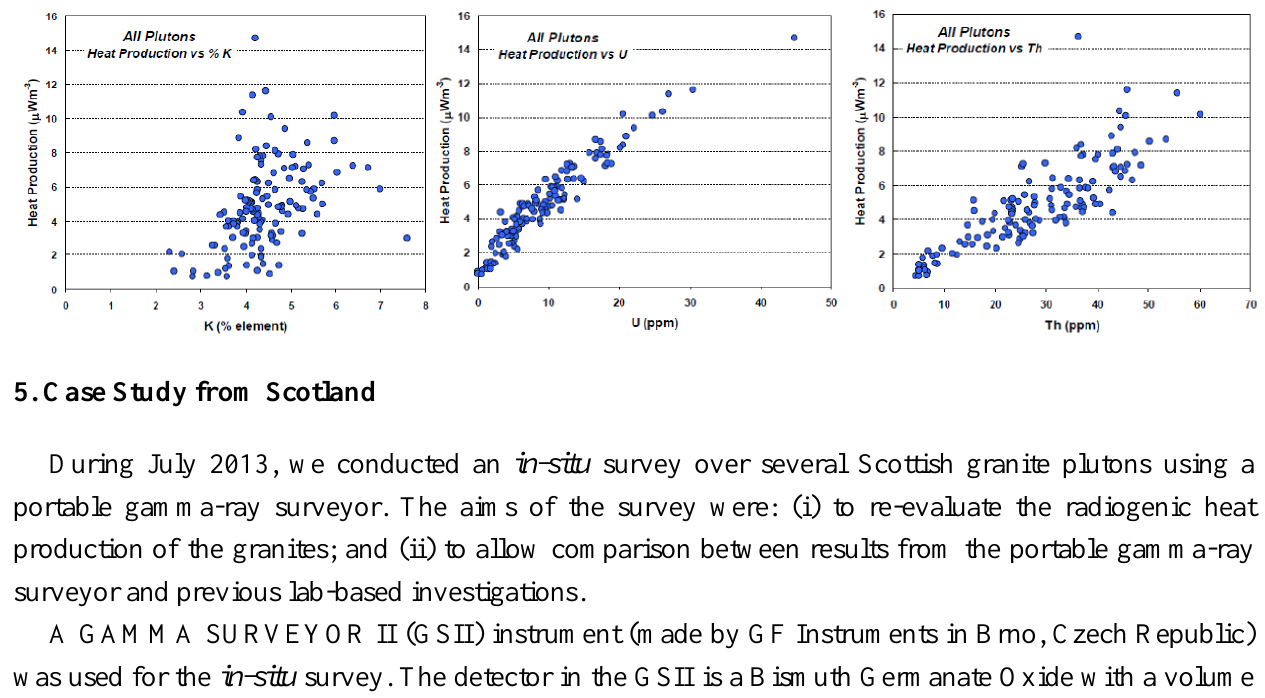
Figure 6. Heat production versus potassium, uranium, and thorium concentrations, for data collected during the Scottish case study described in Section